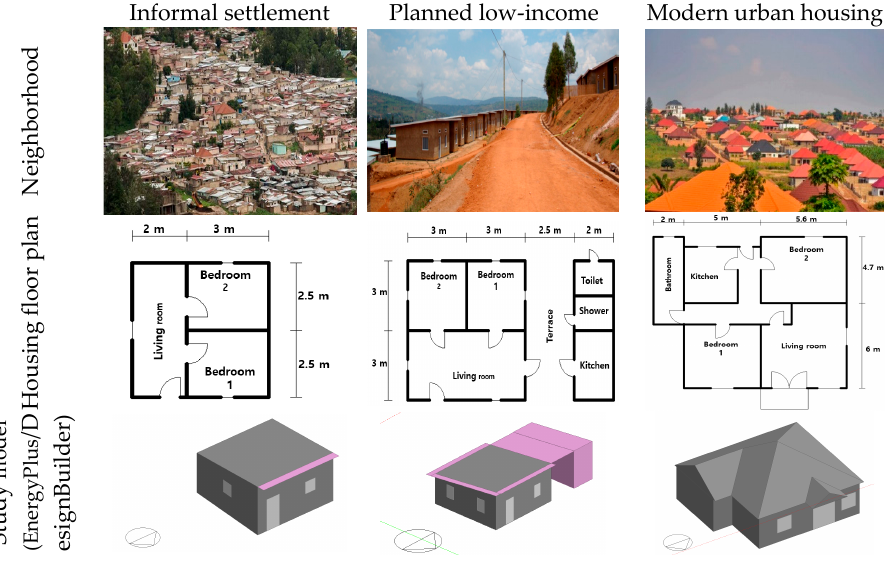
Figure 2. Building types of the current urban fabric in Kigali and the selected study models.